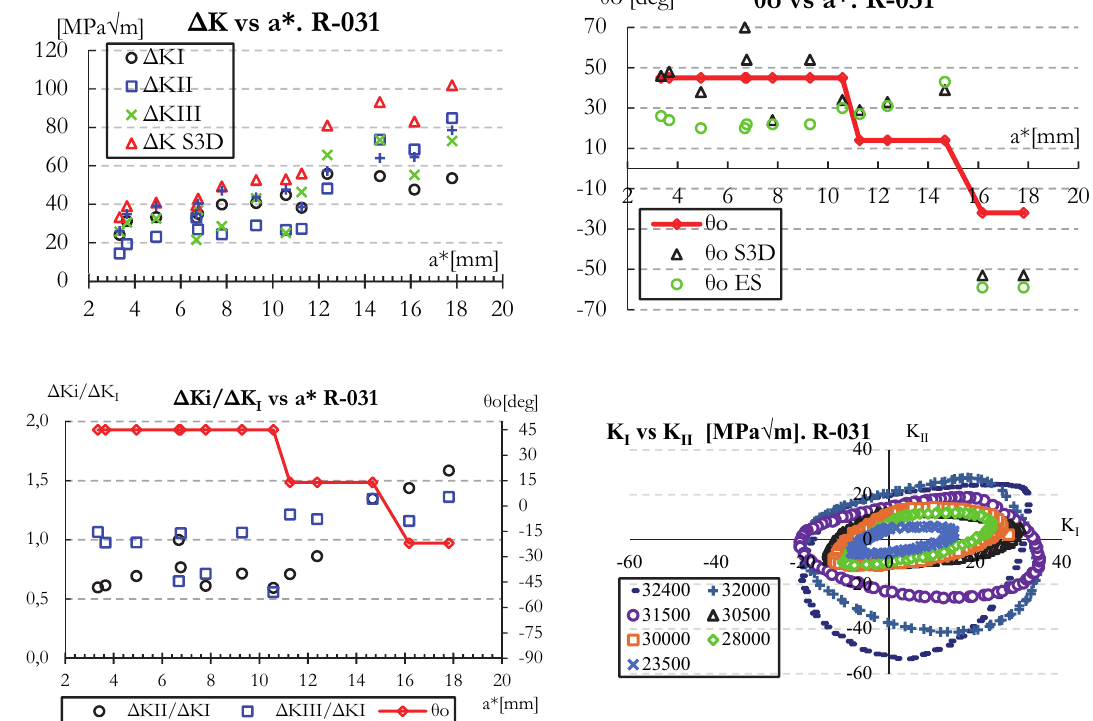
Figure 7: Crack tip parameters measured and calculated for specimen R-031, phase shift 90° between tension 33kN and torsion 382Nm